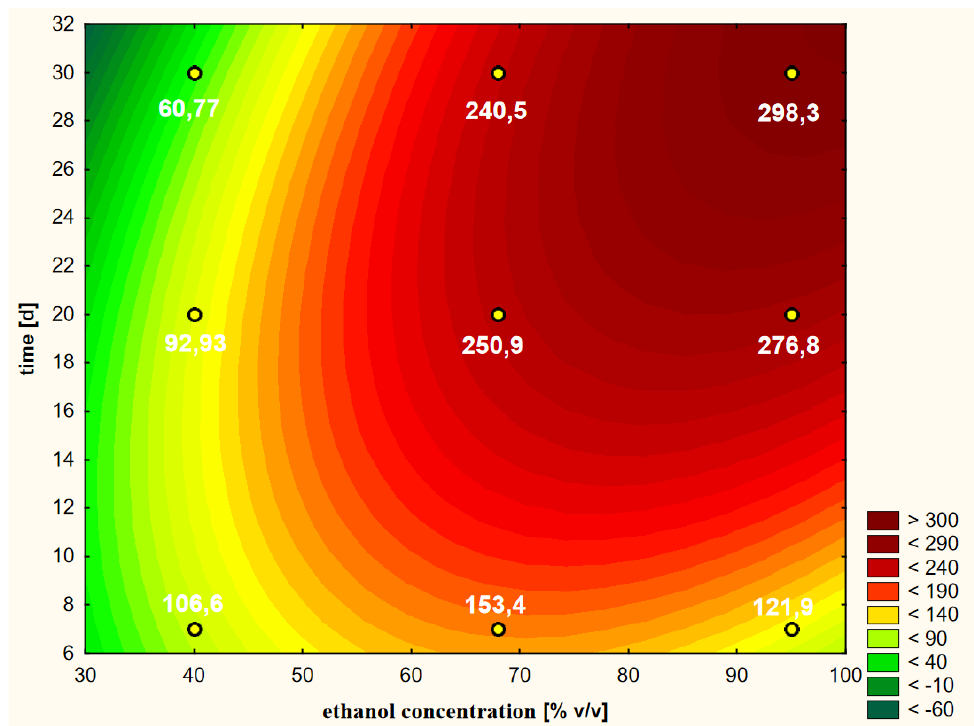
Figure 6. Model of the response surface regarding the contents of chlorogenic acid in ethanol extracts of elderberry flowers obtained from fresh raw material that was initially treated with cold ethanol at a temperature of 25 °C.